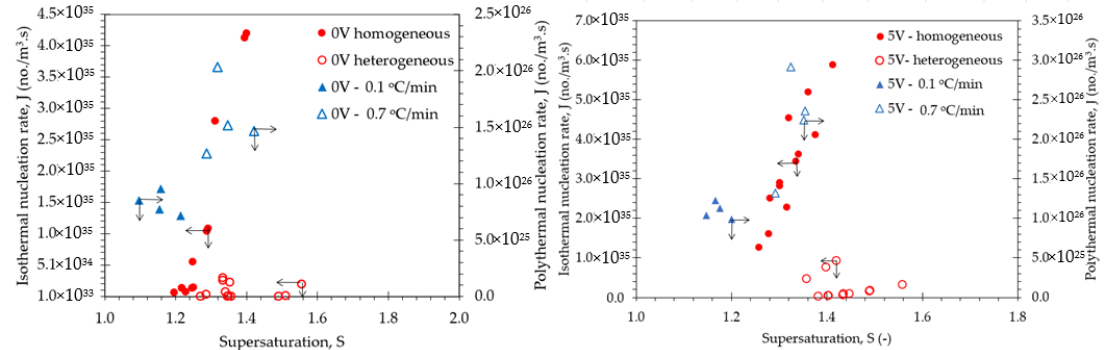
Fig 11 Figure 7. Nucleation rate, J, of polythermal and isothermal crystallisation of L-isoleucine in the aqueous phase under different solution conditions: ( a ) 0 V and ( b ) 5